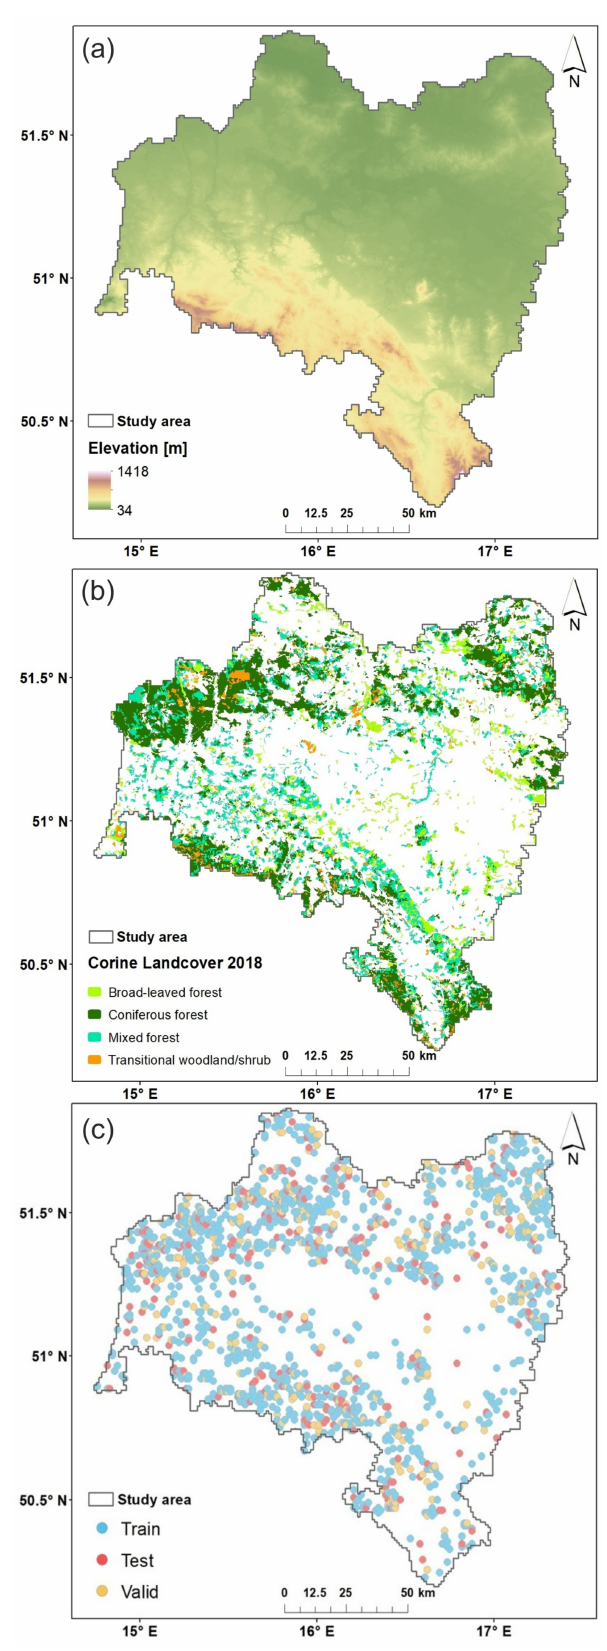
Figure 2. Altitude ( a ); selected CORINE land cover classes ( b ); and training, testing, and validation datasets ( c ) in the study